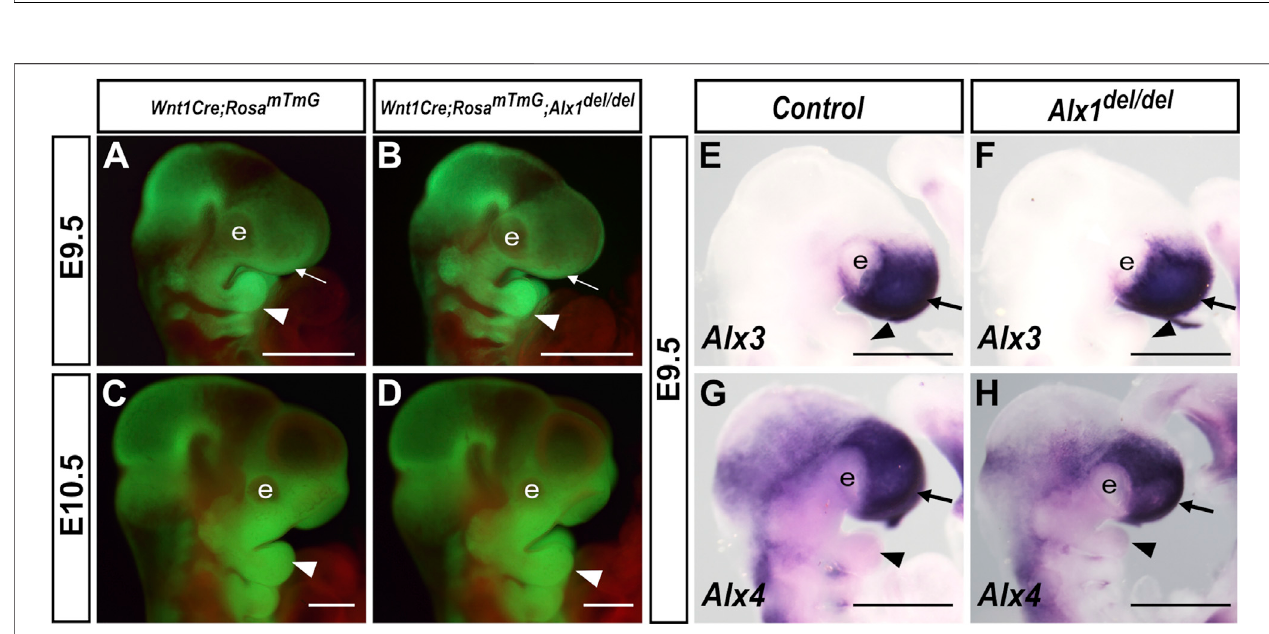
FIGURE 5 | Cranial neural crest migration to the facial primordia and expression of frontonasal neural crest marker genes appeared normal in Alx1 del/del embryos. (A – D) Representative lateral views of whole mount embryo heads showing GFP (green) labeled neural crest cells in the developing facial primordia from Wnt1-Cre; Rosa26 mTmG/+ (A, C) and Wnt1-Cre;Rosa26 mTmG/+ ; Alx1 del/del (B, D) embryos at E9.5 (A, B) , and E10.5 (C, D) . White arrow in A and B points to the frontonasal prominence, whereas the white arrowhead in (A – D) points to the mandibular arch. (E – H) Lateral views of whole mount embryo heads showing expression